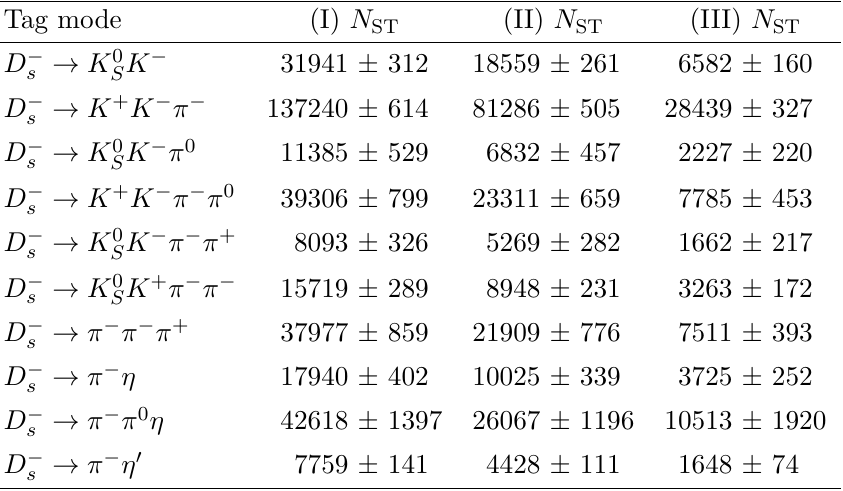
√ s = (I) 4.178 GeV, (II) 4.189–4.219 GeV, and